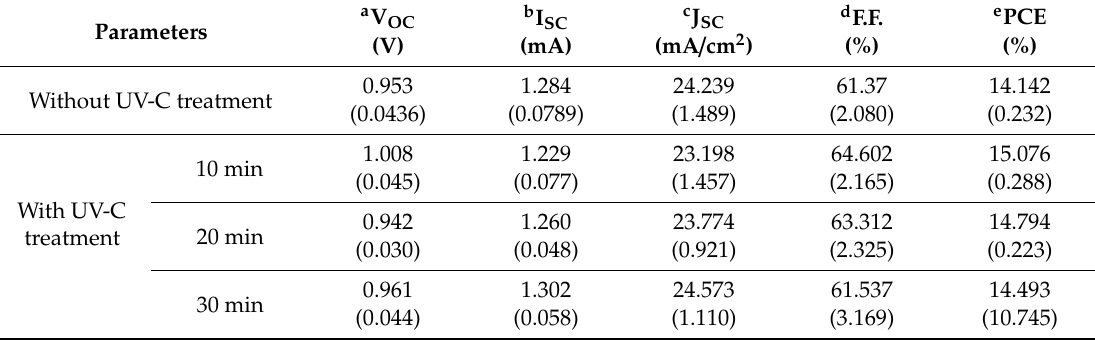
a Open-circuit voltage, b Short-circuit current, c Short-circuit current-density, d Fill Factor, and e Power conversion e ffi